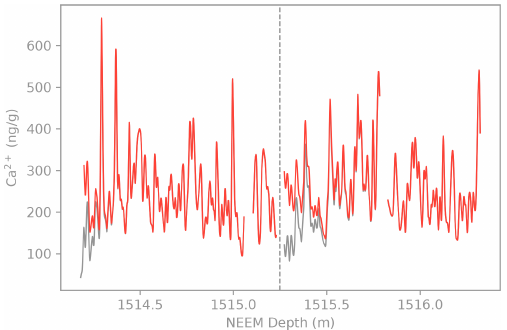
Figure 5. Example of two consecutive measurement runs exhibit- ing the absorption/desorption features caused by the drill-liquid contamination in the CFA system. The two runs are separated by the vertical dashed line. The gray line shows the uncorrected data, the red line is the empirically corrected data (Schüpbach et al., 2018). The correction only affects the beginning of each run. After the ad- sorption/desorption equilibrium is reached, the two lines